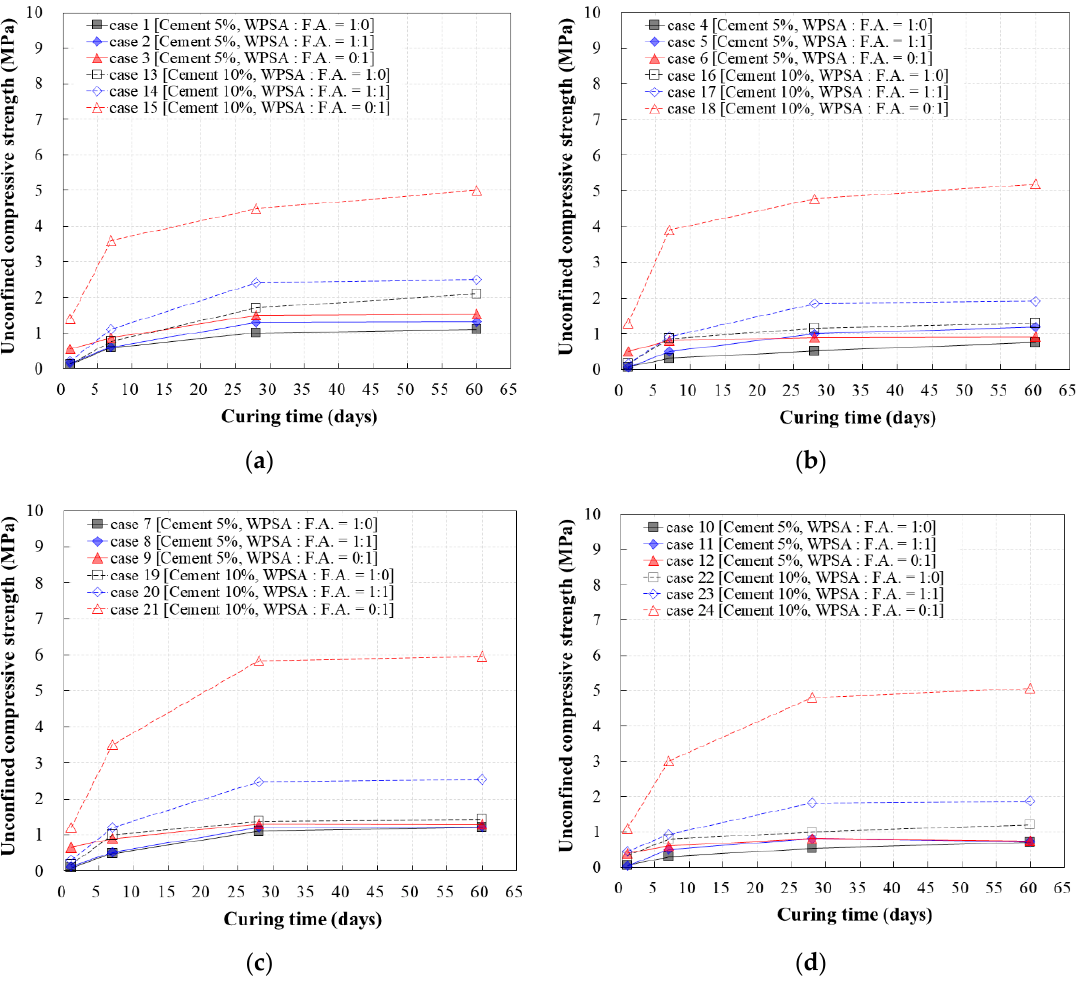
Figure 10. Unconfined compressive strength versus sand content: ( a ) sand 35%; ( b ) sand 40%; ( c ) sand 45%; ( d ) sand 50%.